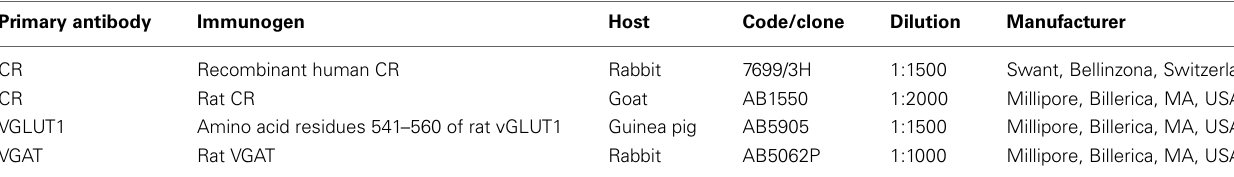
Table 1 | List of primary